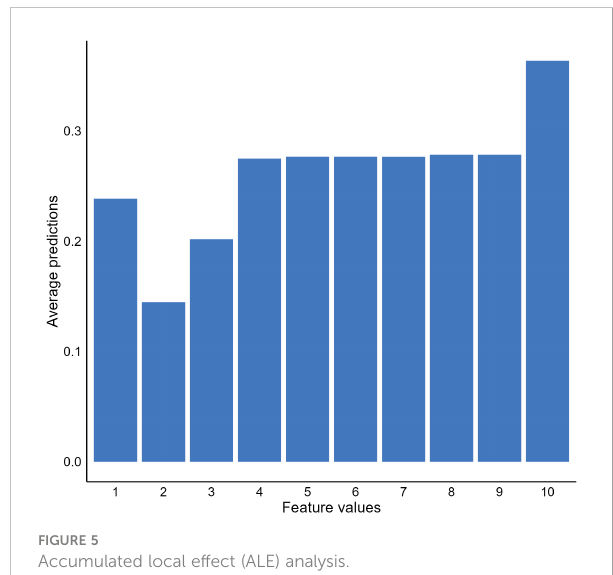
FIGURE 5 Accumulated local effect (ALE)